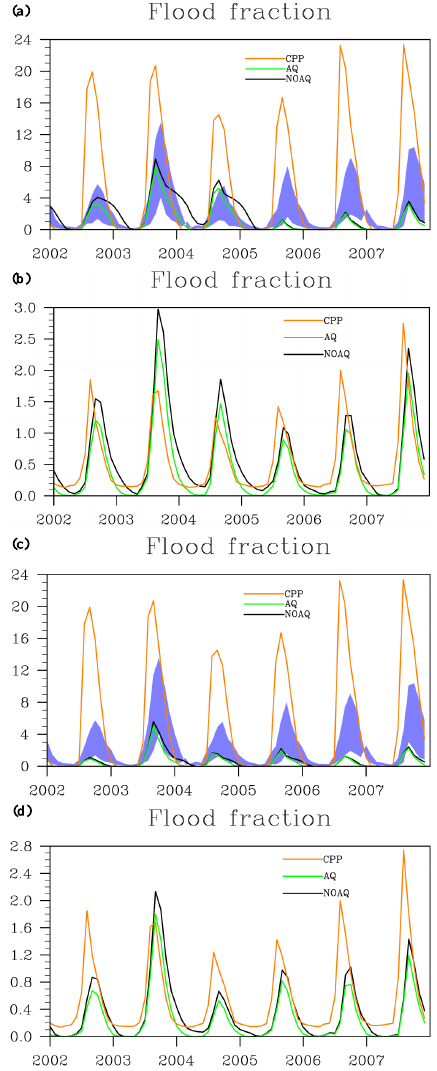
Fig. 7. (a ) Time evolution of the mean monthly flooded fraction (in %) averaged over the inner delta region. The model is forced by TRMM-3B42. The blue range is the interval between the minimum and the maximum Modis classification (JFC) flooded fraction. (b) Time evolution of the mean monthly flooded fraction (in %) av- eraged over the basin. The model is forced by TRMM-3B42. (c) Time evolution of the mean monthly flooded fraction (in %) aver- aged over the inner delta region. The model is forced by RFEH. The blue range is the interval between the minimum and the maximum Modis classification (JFC) flooded fraction. (d) Time evolution of the mean monthly flooded fraction (in %) averaged over the basin. The model is forced by